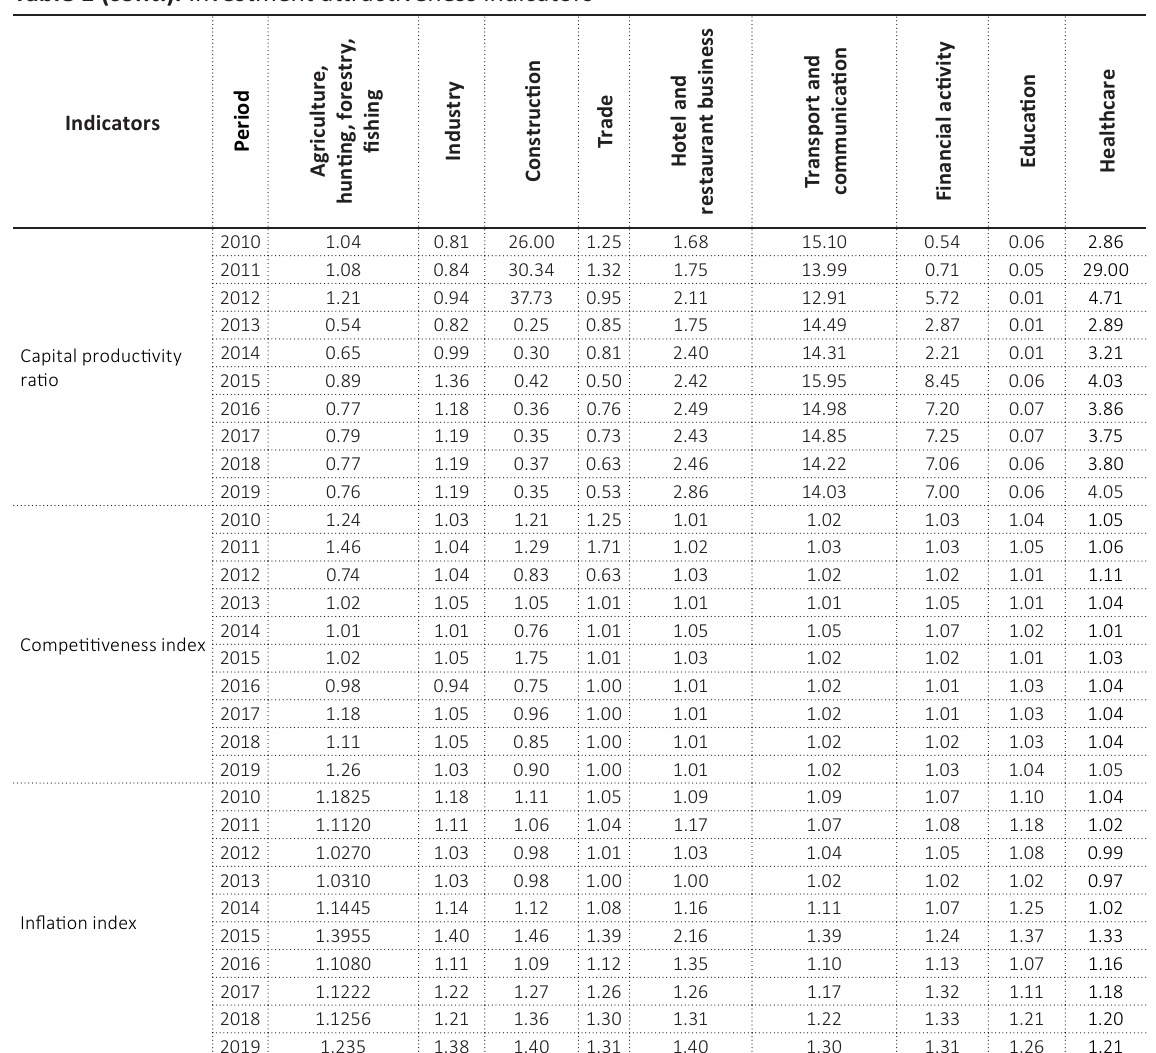
Table 1 (cont.). Investment attractiveness